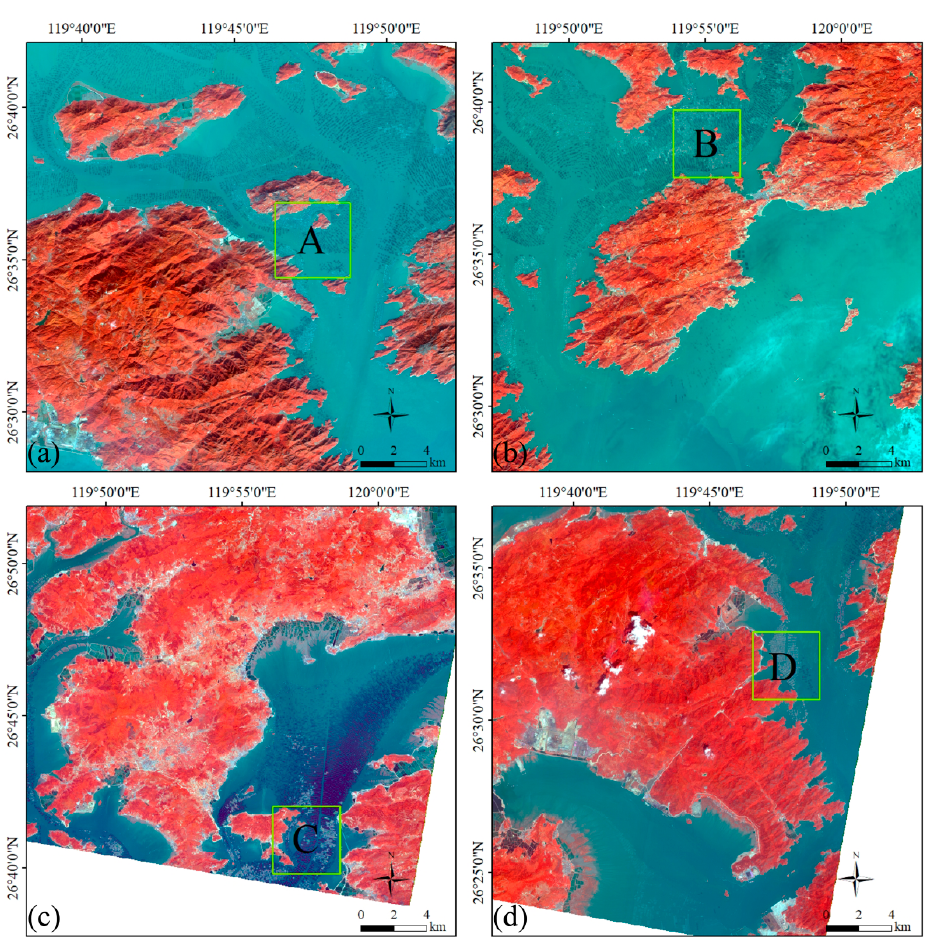
Figure 7. Training data (false color: band combination 421). ( a ) Training data A and B from Novem- ber 2013. ( b ) Training data C from November 2013. ( c ) Training data D and E from November 2017.